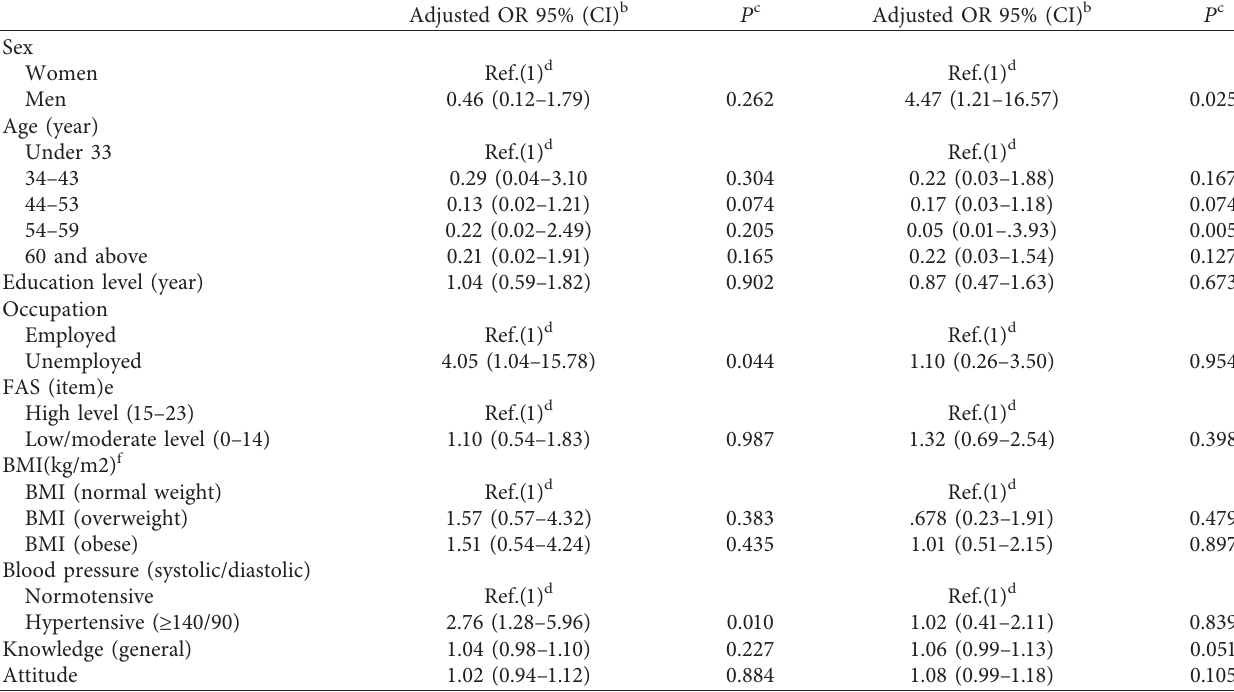
Table 6: Results of logistic regression analysis for adding salt during cooking and eating food (0 � 1 tsp a or less and 1 � more than 1tsp a